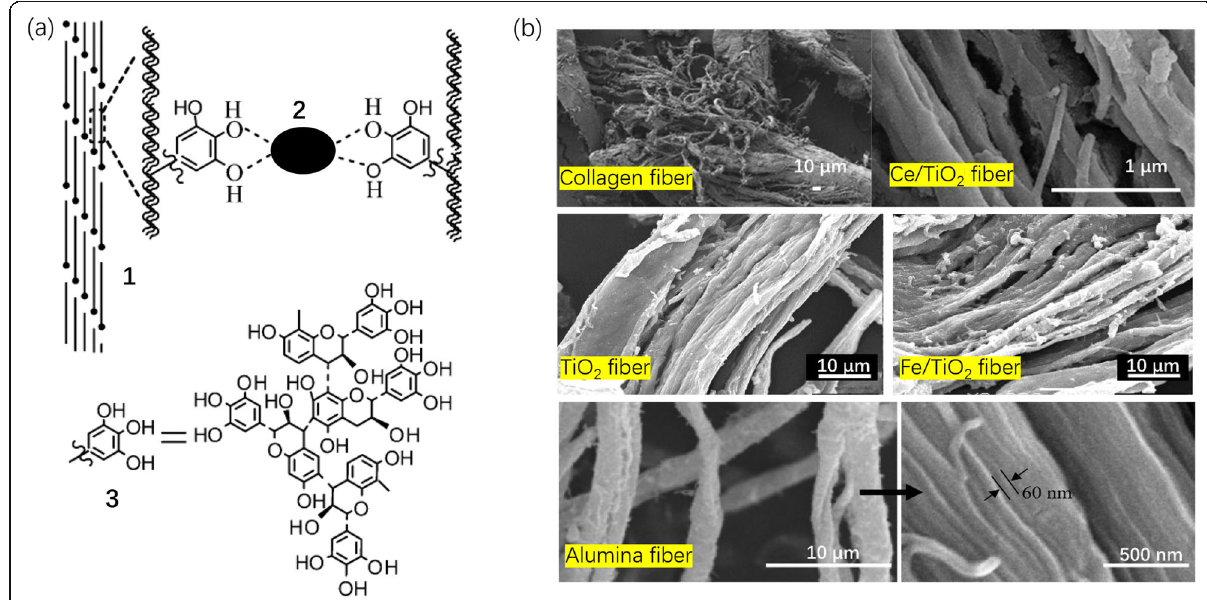
Fig. 4 (a1) Longitudinal view of collagen molecules in staggered array; (a2) metal ions chelateded with collagen fiber via black wattle tannin; (a3) Black wattle tannin; SEM of skin collagen fiber (SCF) and metal fibers using CF as templates [42, 44, 52], Copyright (2008), with permission